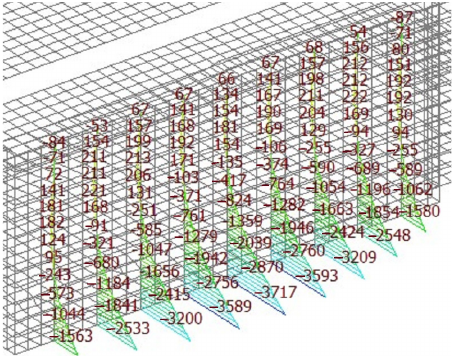
Figure 15. The bending moment of the wall column under three-dimensional simulation model (unit: